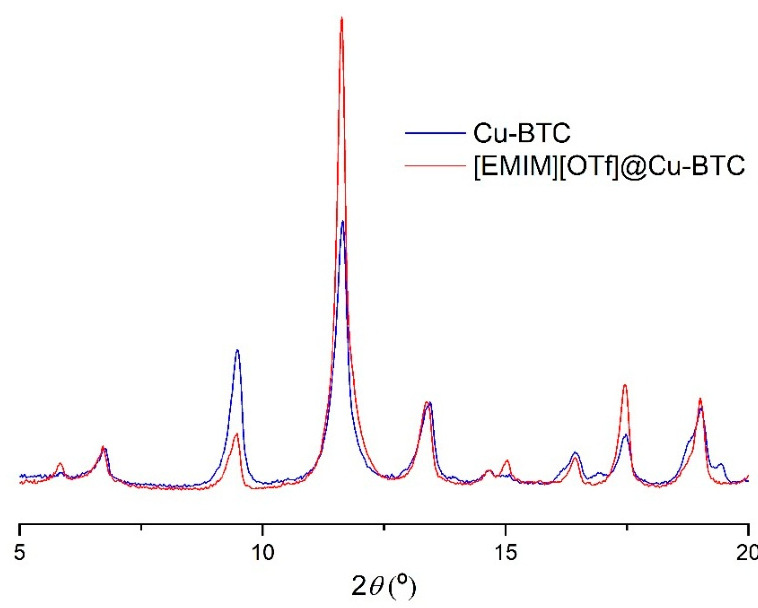
Figure 5. Powder XRD pattern for the precursor Cu-BTC (blue line) and the [EMIM][OTf]@Cu-BTC composite (red line).